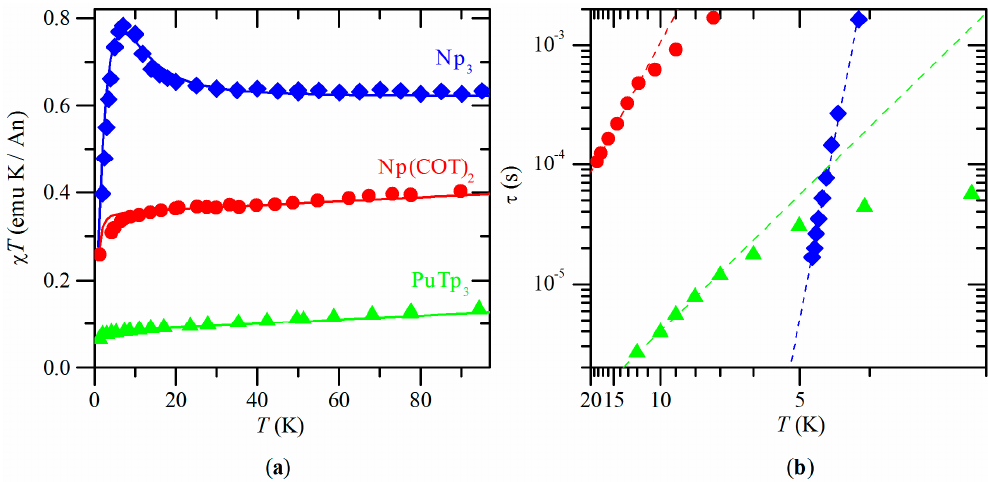
Figure 2. ( a ) Temperature ( T ) dependence of the dc magnetic susceptibility per actinide ion ( χ ), plotted as χ T vs. T curves. Points are experimental data (blue diamonds: Np 3 , red circles: Np(COT) 2 , green triangles: PuTp 3 ), lines are calculations (see main text for details); ( b ) Arrhenius (log-reciprocal) plot of the relaxation time τ as a function of T . Points (same legend as for the other panel) are experimental data derived from ac susceptibility measurements, dashed lines are fits of the high-temperature points to an Orbach law τ = τ 0 exp( U eff / kT ). All data, fits and calculations are from references [21–23].